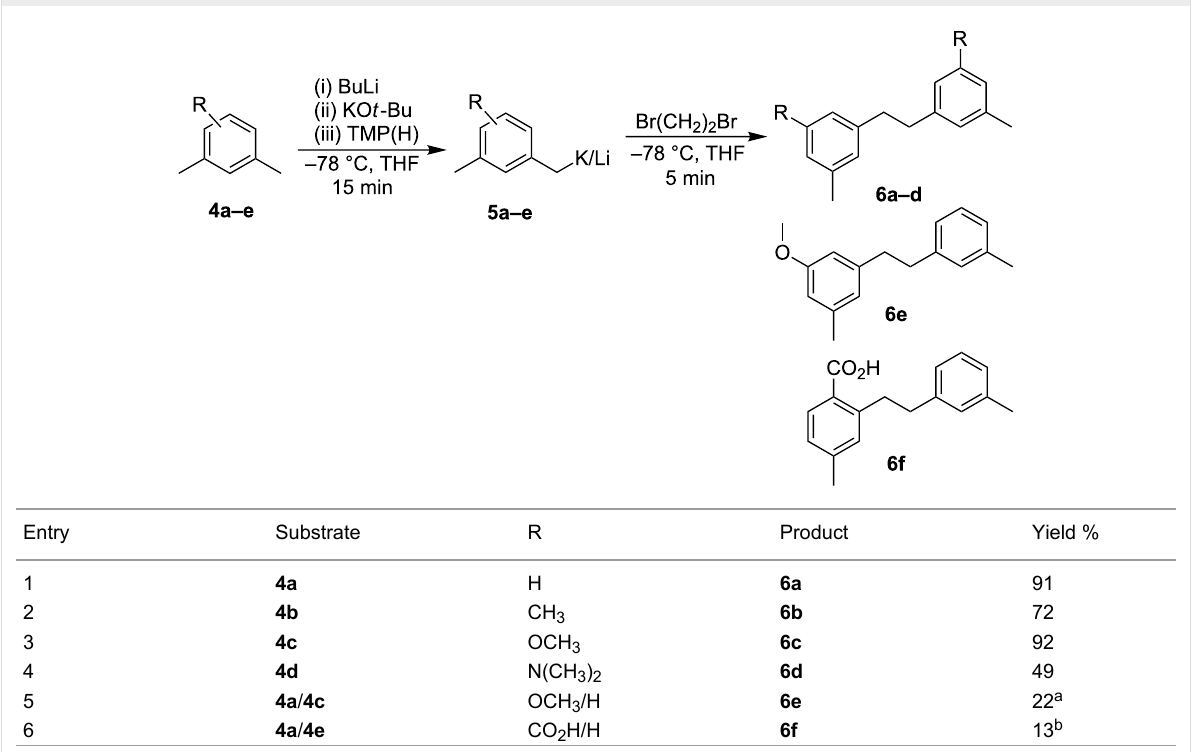
Table 1: Oxidative coupling of benzylic metalated xylenes 4